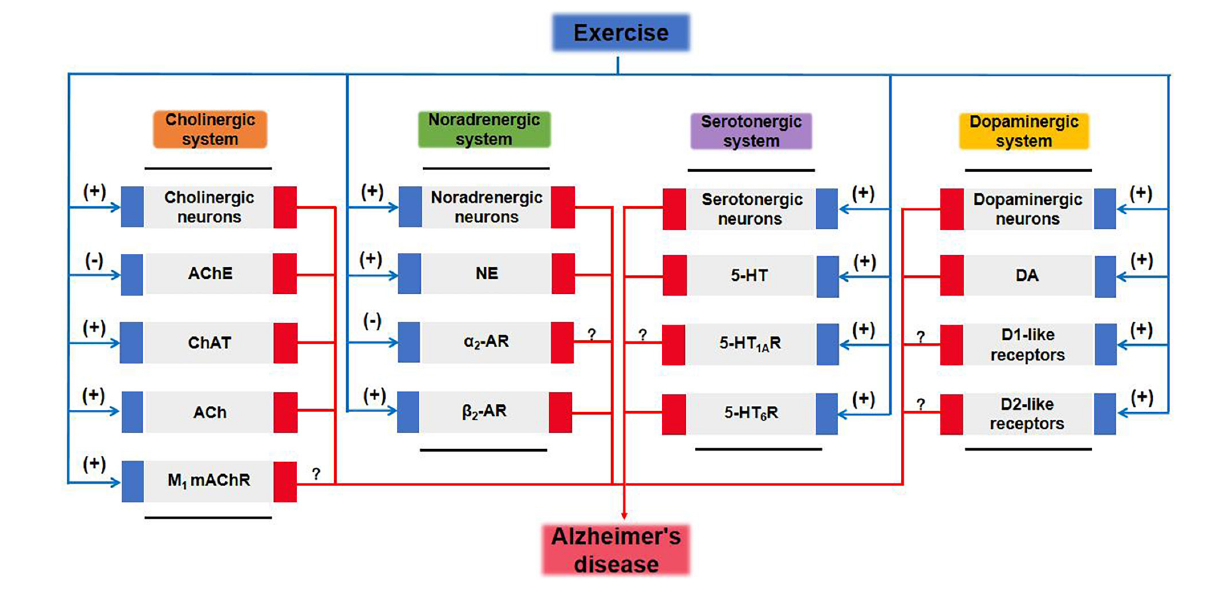
Frontiers in Aging Neuroscience |